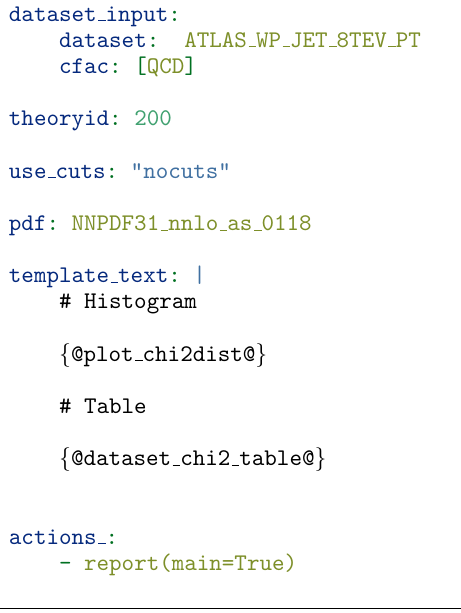
Fig. 3 A validphys runcard which produces a report containing a table and a histogram with the χ 2 values obtained for the ATLAS W + + jets 8 TeV differential distributions when using the N rep = 100 replicas of NNPDF3.1 NNLO as input dataset and the theory settings specified by the theoryid: 200 of the database. In particular, the runcardspecifiesthestringforthe dataset ,theuseofQCD K -factors, and the requirements that no kinematic cuts should be applied to the input dataset. Possible input options are referenced in Sec. 2. The DAG graph corresponding to the execution of this runcard is represented in Fig.